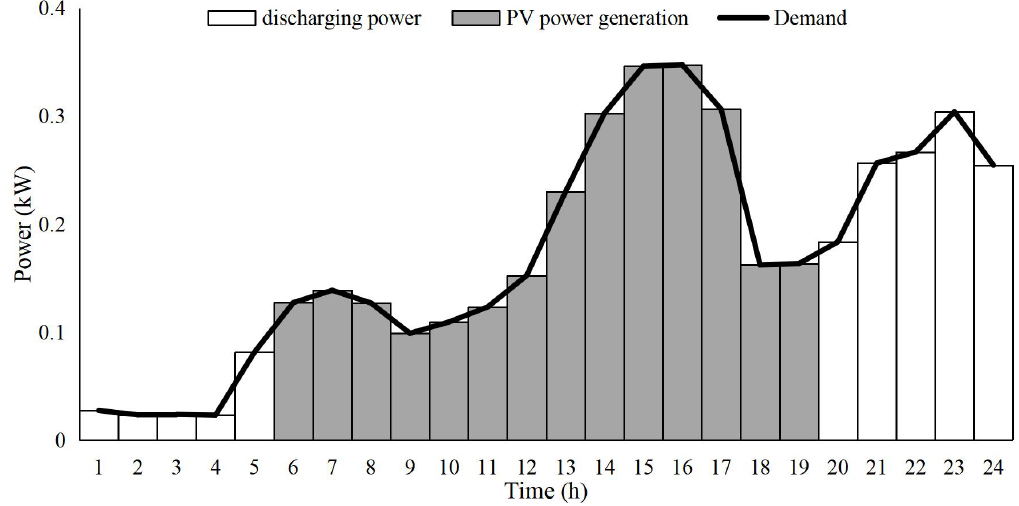
Figure 6. Results of supplying the demand for Case I in Zone 1 on a summer day.